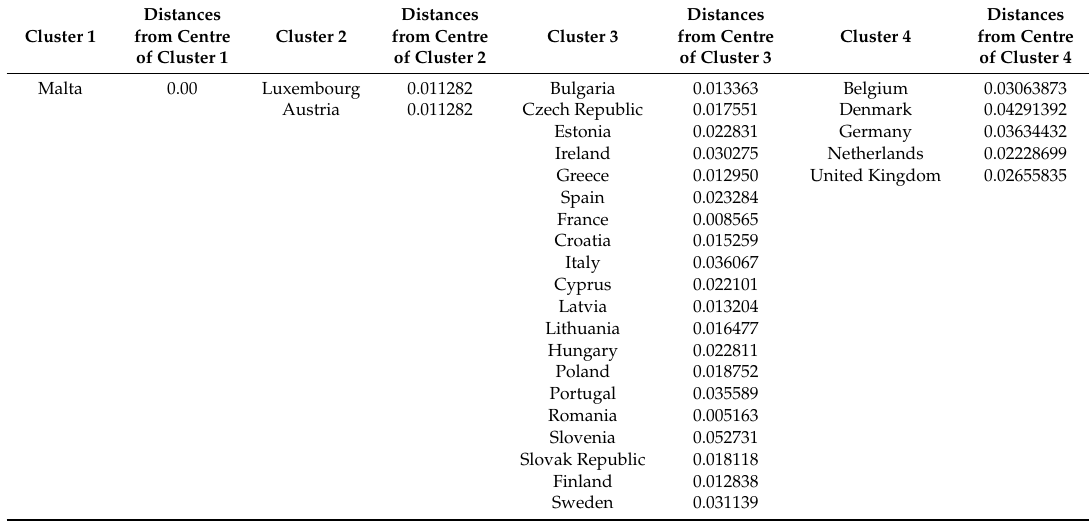
Table 22. Elements of clusters with distances from centers (own study).